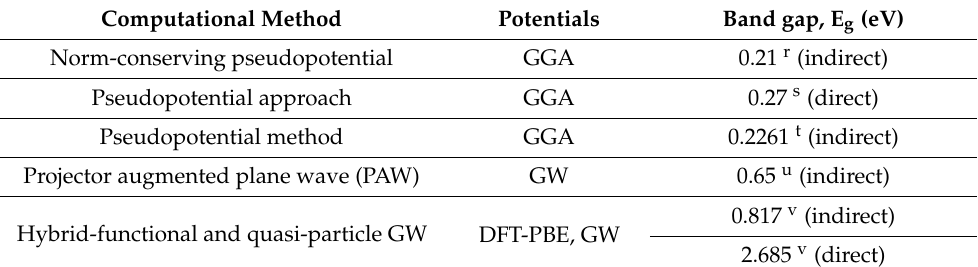
Table 2. Cont. Computational Method Potentials Norm-conserving pseudopotential Pseudopotential approach Pseudopotential method Projector augmented plane wave